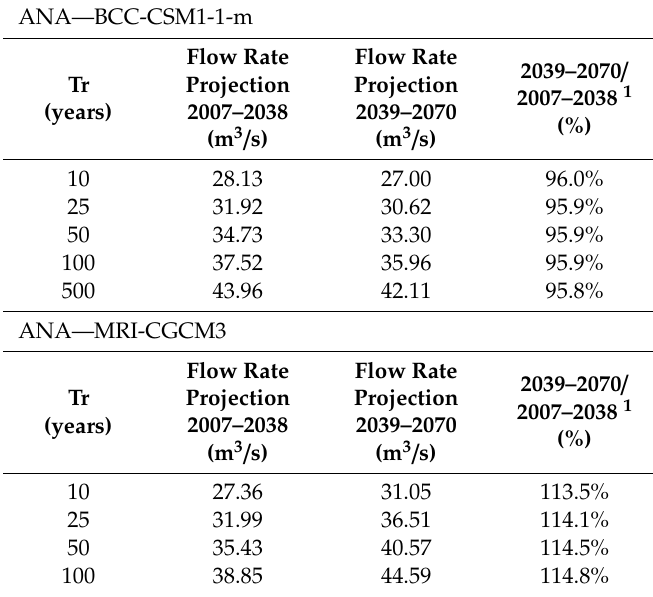
Table 2. Return period, daily flow rate projection, 1st Stage (2007–2038); daily flow rate projection ratio, 2nd Stage (2039–2070); and flow rate ratio (2nd Stage / 1st Stage).